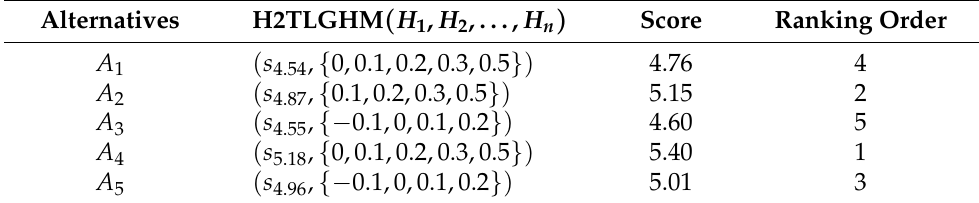
Table 13. Ranking of alternatives by using H2TLGHM operator when p = 2, q =